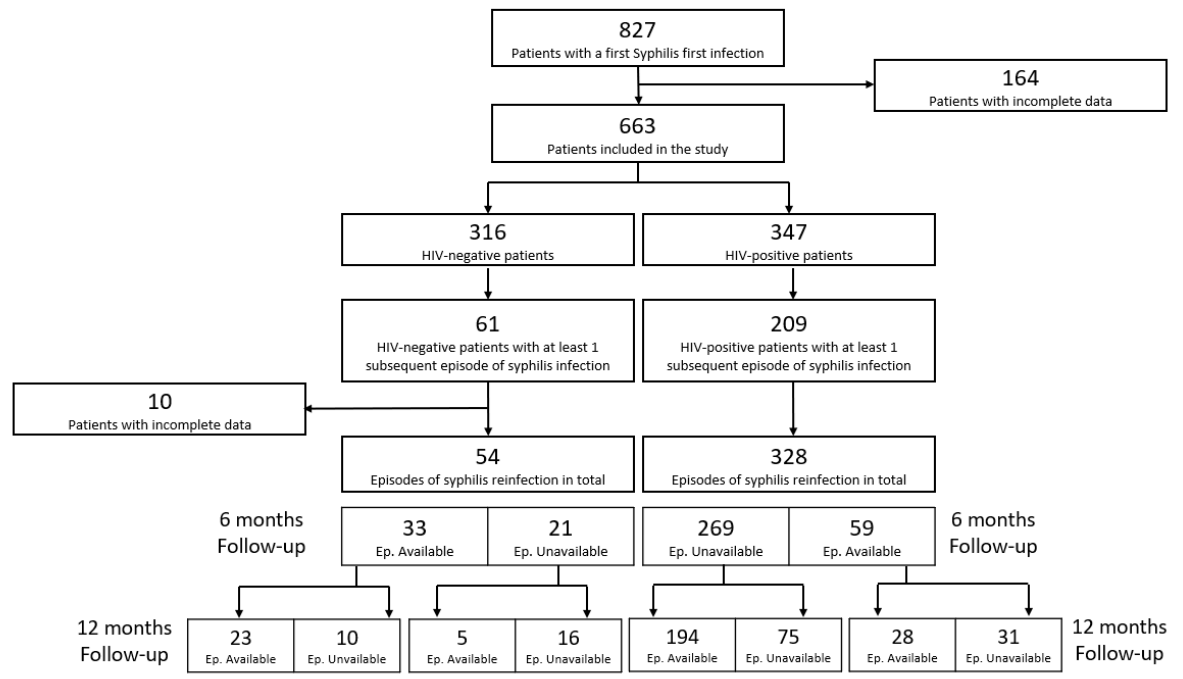
Figure 1. Study design (Ep. = episodes).